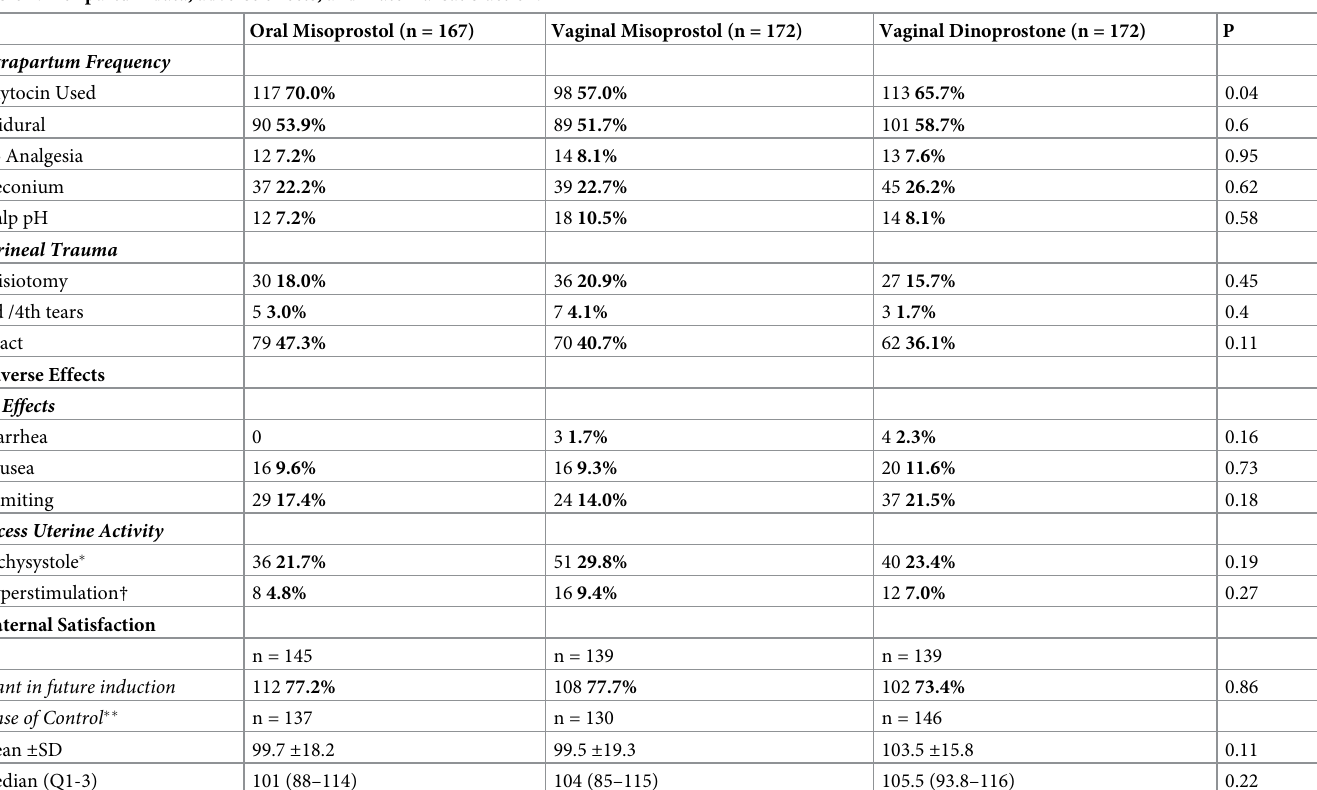
Table 2. Peripartum data, adverse effects, and maternal